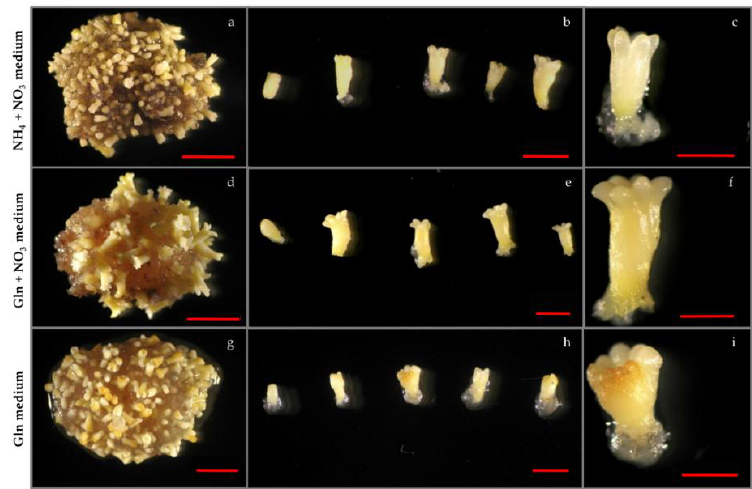
Figure 3. Mature somatic embryos of Norway spruce cell line 11:12:02 after six weeks on maturation media followed by two weeks on corresponding synchronization media: ( a – c ) NH 4 + NO 3 ; ( d – f ) Gln + NO 3 and ( g – i ) Gln. Left bars = 5 mm; middle bars = 2 mm; right bars: 1 mm.